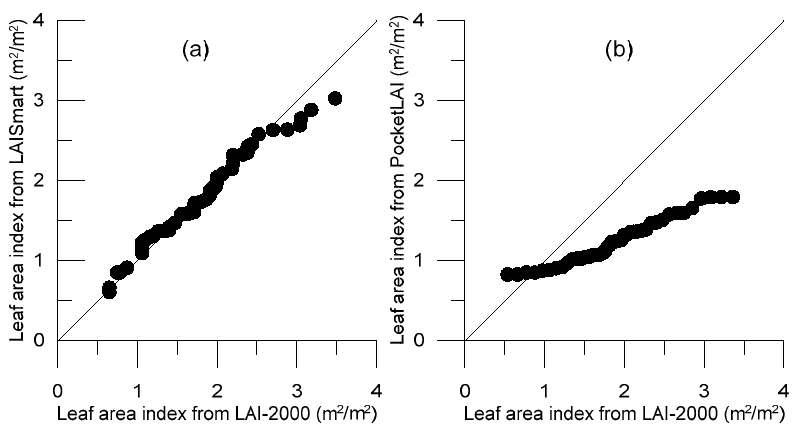
Figure 4. The Q-Q plot of two smartphone sensor methods with the LAI-2000 instrument. The similar quantile-quantile plot around y = x line of LAISmart and LAI-2000 ( a ) indicates that they share a same distribution, while the PocketLAI measurement can’t be taken as a same distribution of LAI-2000 as there is much bias to the y = x line ( b ).